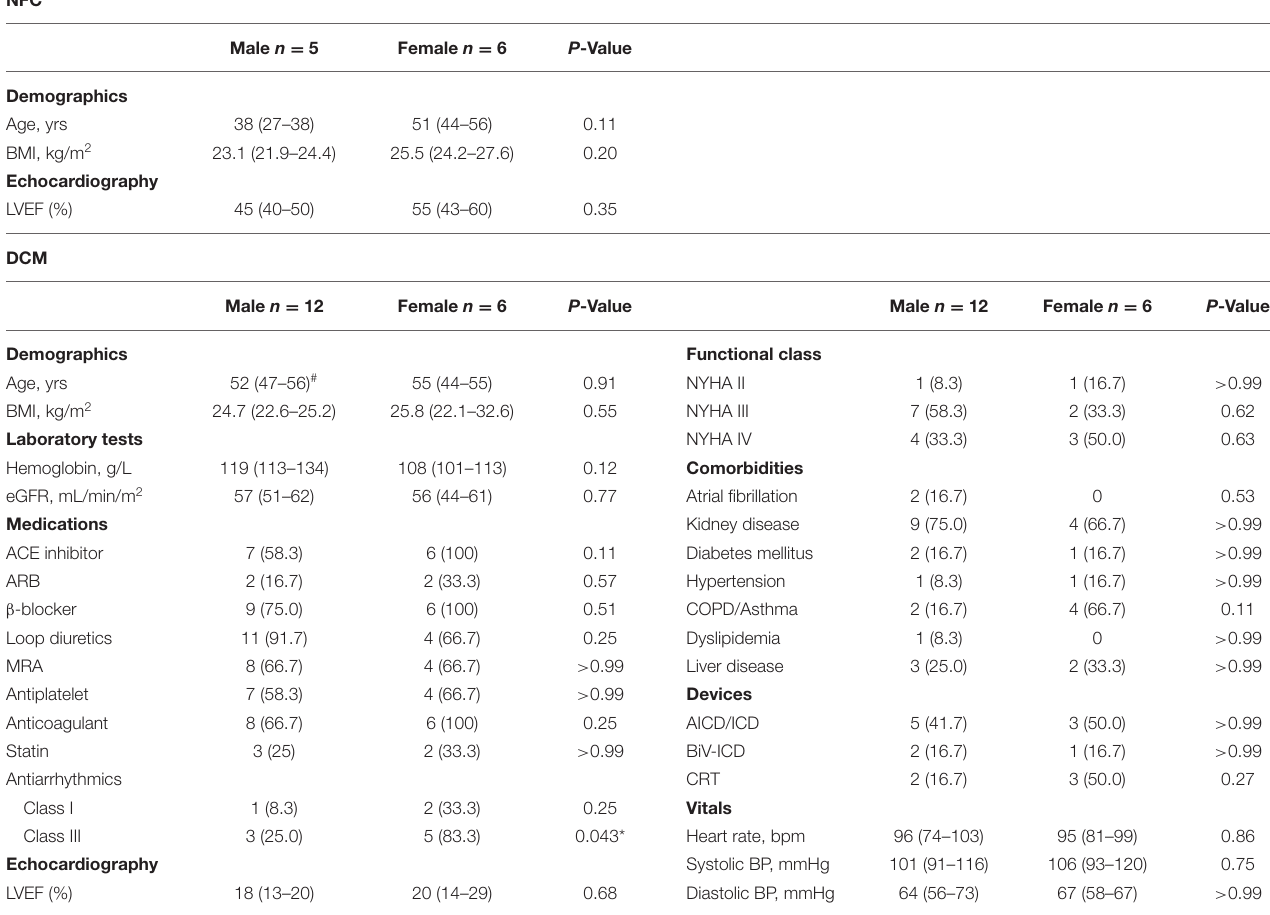
TABLE 1 | Demographic and clinical parameters of patients acquired from electronic medical